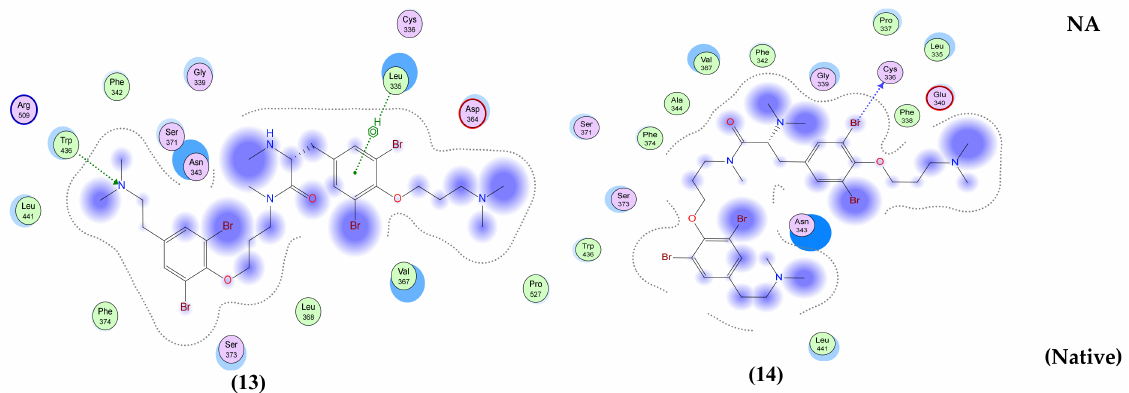
Figure 5. The 2D interactions of the 14 library compounds in addition to the native ligand with spike glycoprotein (PDB ID: 6VYB). NA: Non